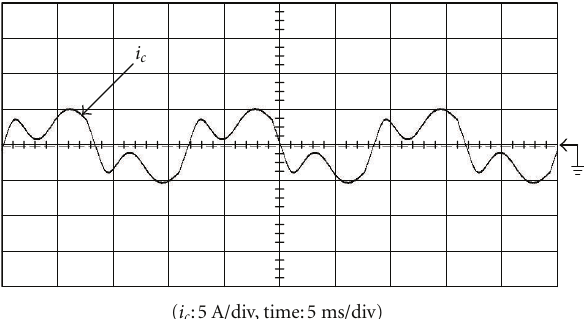
Figure 19: The corresponding inverter current during the interval of medium insolation.